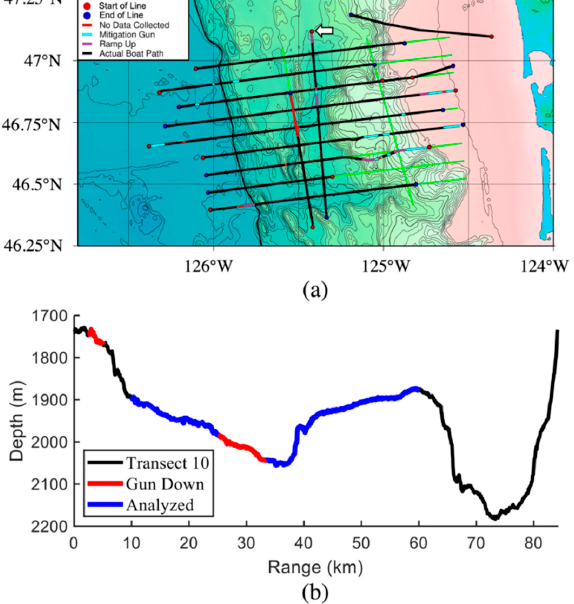
Figure 1. ( a ) Layout of the COAST experiment from Holbrook et al. [29], conducted off the coast of Washington state in July 2012. Each line represents the ship’s path while towing an ~8 km streamer with 636 receivers spaced 12.5 m and a source array of 36 airguns at 4.5 knots. The white arrow indicates the beginning of the analyzed transect. Data were collected by coordinated firing of the airgun array approximately every 50 m and recording for 16.384 s. ( b ) The bathymetry of transect 10 is shown here as a function of the ship location with blue indicating the ship location for the analyzed signal pulses.